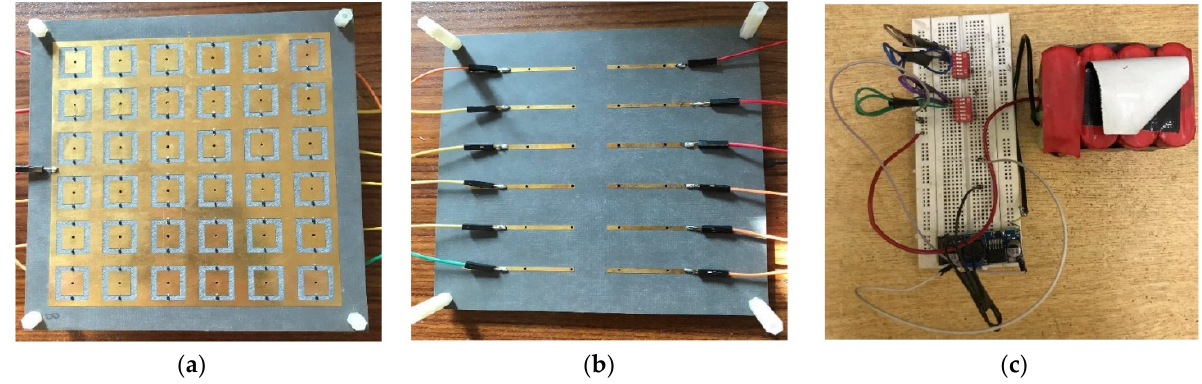
Figure 8. Fabricated Structure along with Biasing Network ( a ) Top-view ( b ) Bottom-view ( c ) DC Biasing Circuitry.